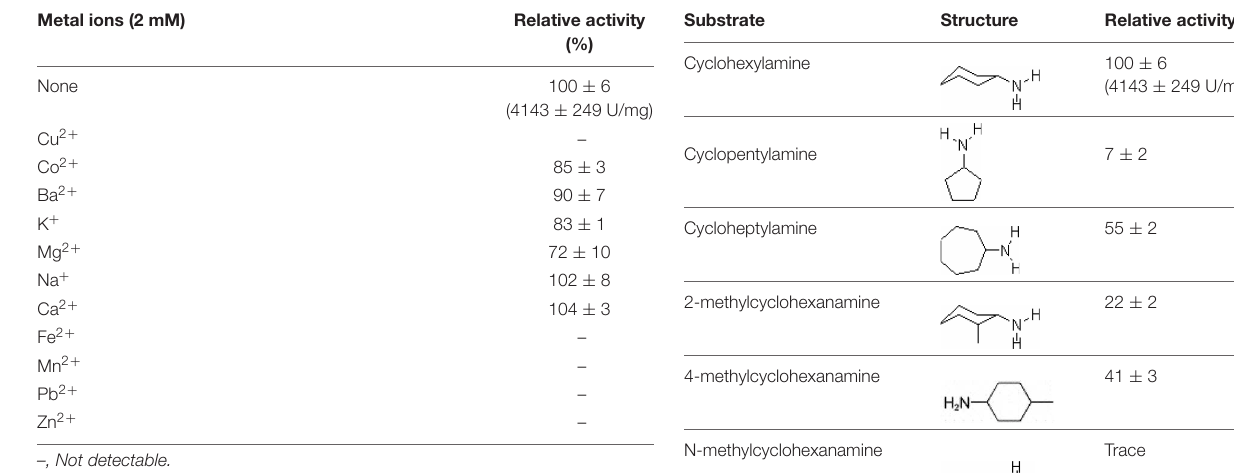
TABLE 1 | Effects of metal ions on the activity of CHAO YT − 02 . TABLE 2 | Activity of recombinant CHAO YT − 02 toward different amine